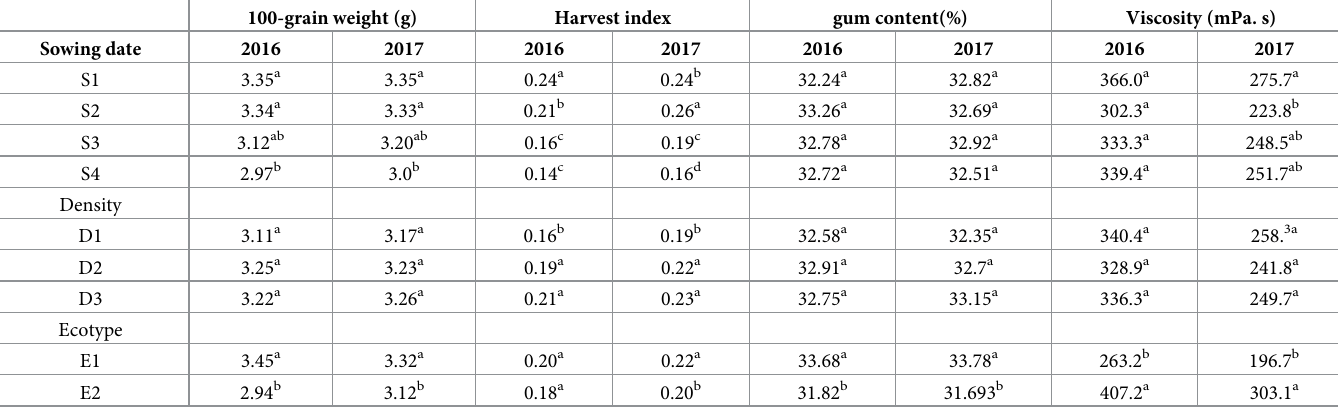
Table 5. Grain weight, harvest index, gum content and viscosity affected by sowing date, plant density and ecotype. 100-grain weight (g) Harvest index gum content(%) Viscosity (mPa.